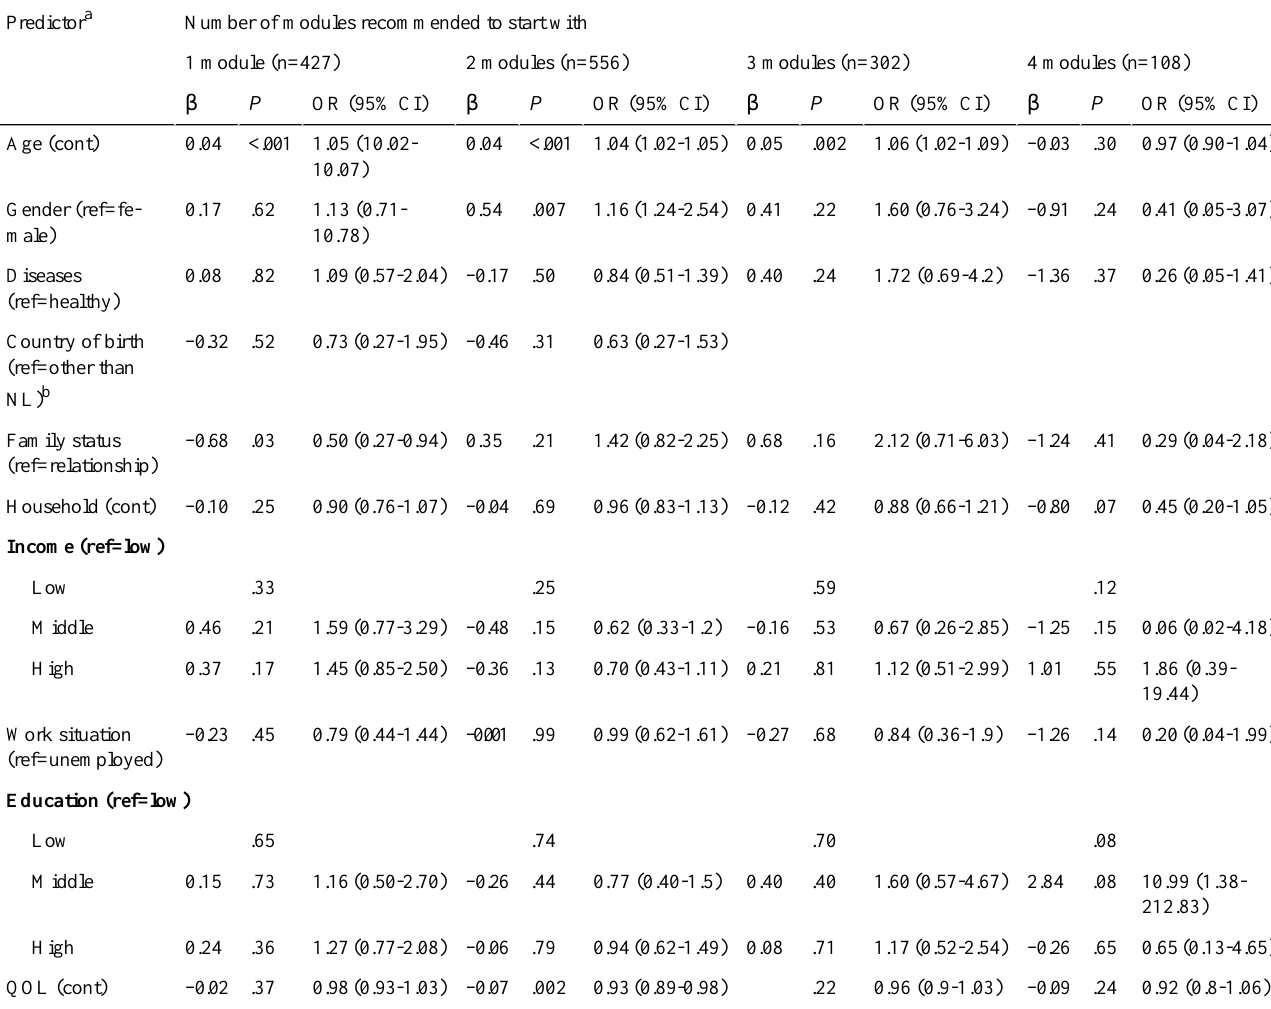
Table 2. Logistic regression results for the relationship between socioeconomic variables, personal characteristics, and following the intervention